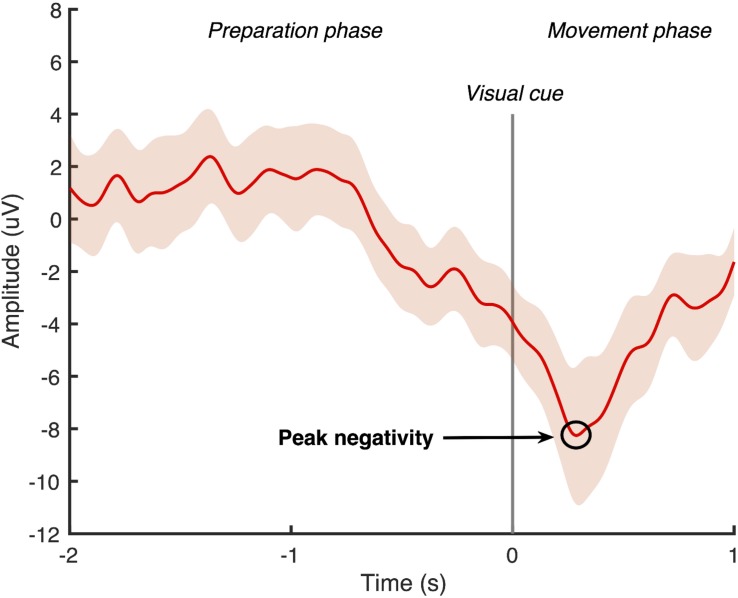
Epoch-averaged MRCP with 95% confidence interval for one participant with chronic stroke (epochs = 47). Visual cue to move is delivered at 0 s and peak negativity occurred 286 ms after visual cue.